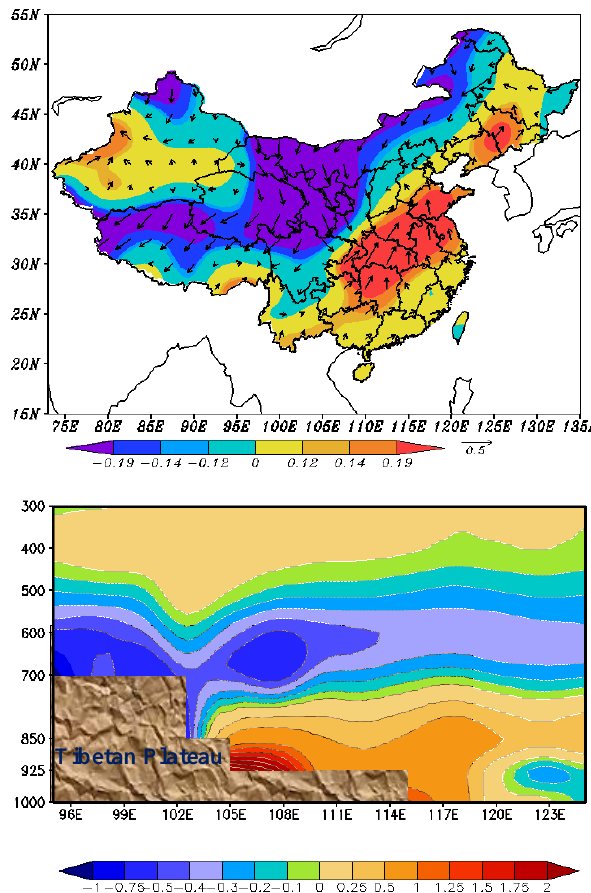
Figure 5. The distributions of the interannual correlations of the apparent heat source Q 1 over the TP to the local V -component of surface wind in winter over 1961–2012 (color shading). Arrows de- note correlation vectors (showing both correlation coefficients of Q 1 to U - and V -surface wind components) in China. The corre- lation coefficients of 0.12 (-0.12), 0.14 ( − 0.14) and 0.19 ( − 0.19) respectively passing the significance levels of 90, 95 and 99%. A vertical section of the trends in vapor content (gkg − 1 per 10 years) in winter over 1961–2012 averaged along 27–41 ◦ N (lower